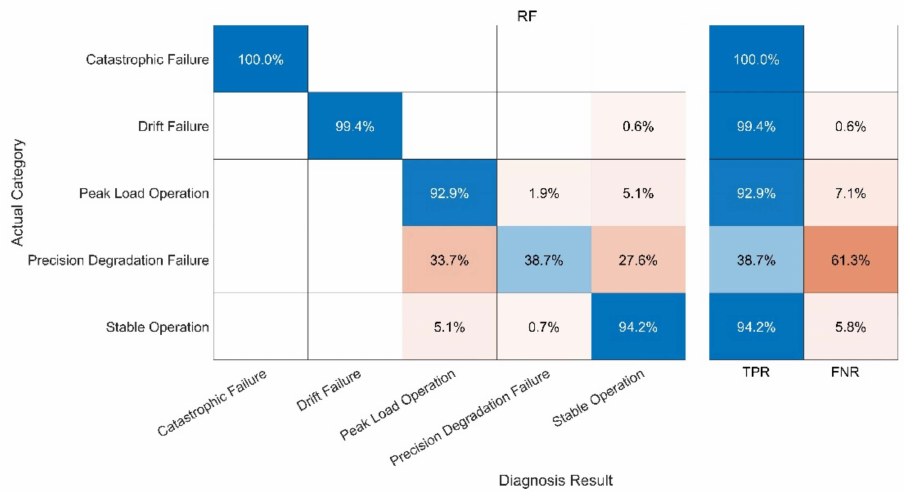
Figure 15. Fault Diagnosis Result of